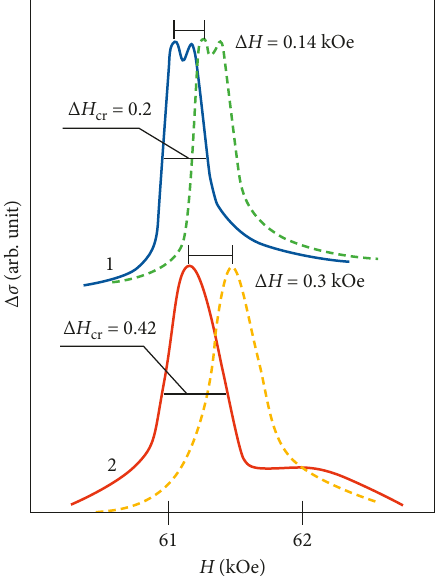
Figure 15: The prebreakdown line-width (solid lines) and the line- shift of the CR spectroscopy at breakdown (dashed lines) for sample 1 (curve 1) and sample 6 (curve 2) at λ ≈ 119 μ m.